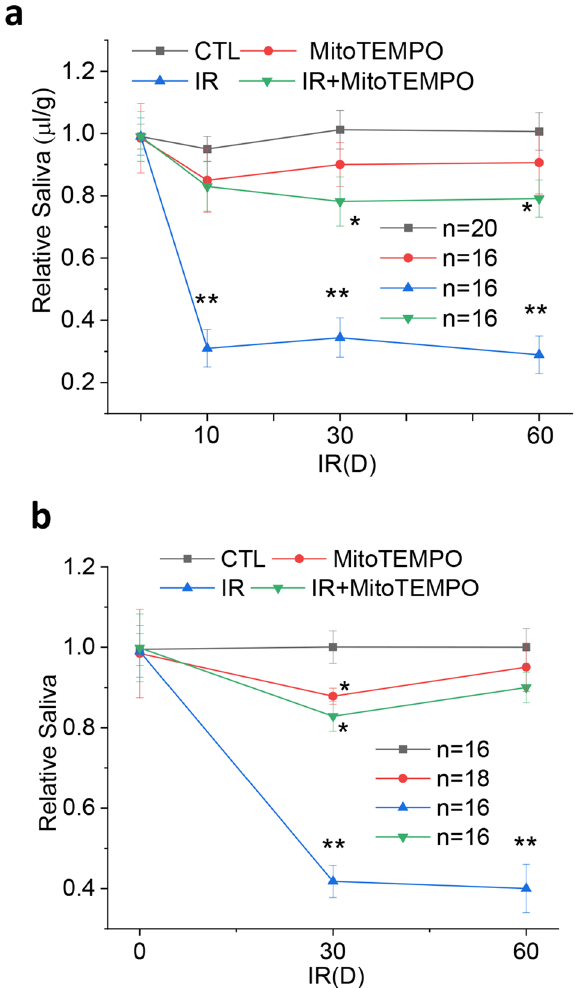
Figure 4. MitoTEMPO rescued the loss of salivary fluid secretion in irradiated mice. ( a ) Pilocarpine-stimulated salivary fluid secretion was monitored in control mice (CTL), irradiated mice (IR), and mice receiving MitoTEMPO with or without IR, on day 0 (24 h prior to IR) and days 10, 30 and 60 after IR. MitoTEMPO was given at 5 mg/kg i.p. 10 min before IR, 24 h after irradiation, followed by a 2.5 mg/kg 48 h after IR. 16 to 20 mice were used as indicated and data are presented as mean ± SEM. *P < 0.05, indicated values that are significantly different from CTL values at the same time point and **P < 0.01, indicate values that are significantly different as compared to control and MitoTEMPO treated (no IR) at the same time points (unpaired t test). ( b ) Pilocarpine-stimulated salivary fluid secretion was monitored in the same groups of mice; CTL, MitoTEMPO, IR, IR + MitoTEMPO on day 0 (24 h before IR) and on days 30 and 60 after IR. In this case mice were delivered fractionated IR (IR-f, 3 Gy per day for 5 consecutive days) MitoTEMPO was administered at a dose of 1 mg/kg i.p. 10 min before each IR for 5 days and then repeated for every 24 h for 3 more days. 16 to 18 mice were used as indicated. Mean ± SEM, *P < 0.05, indicated values that are significantly different from CTL values at the same time point and **P < 0.01, indicate values that are significantly different from all other groups values at the same time point (unpaired t